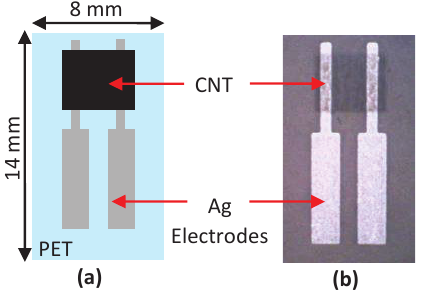
Fig. 3.- Experimental set-up. Figure 12. Experimental setup for the tin oxide-doped optical sensor